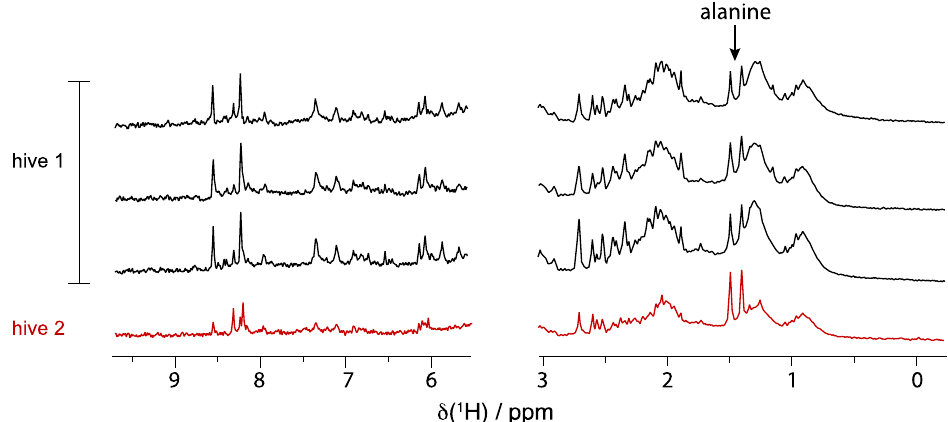
Figure 7. Representative low-field 1 H-NMR spectra (80 MHz; composite pulse presaturation experiment with 512 transients, 2.5 s acquisition time, and 10 s combined saturation time and recycle delay) of the aqueous metabolome of acetonitrile extracts of single bees show good sensitivity in short acquisition times, accomplished in part by restricted volume sample tubes (5 mm/2.5 mm) employing 180 μ L of sample.